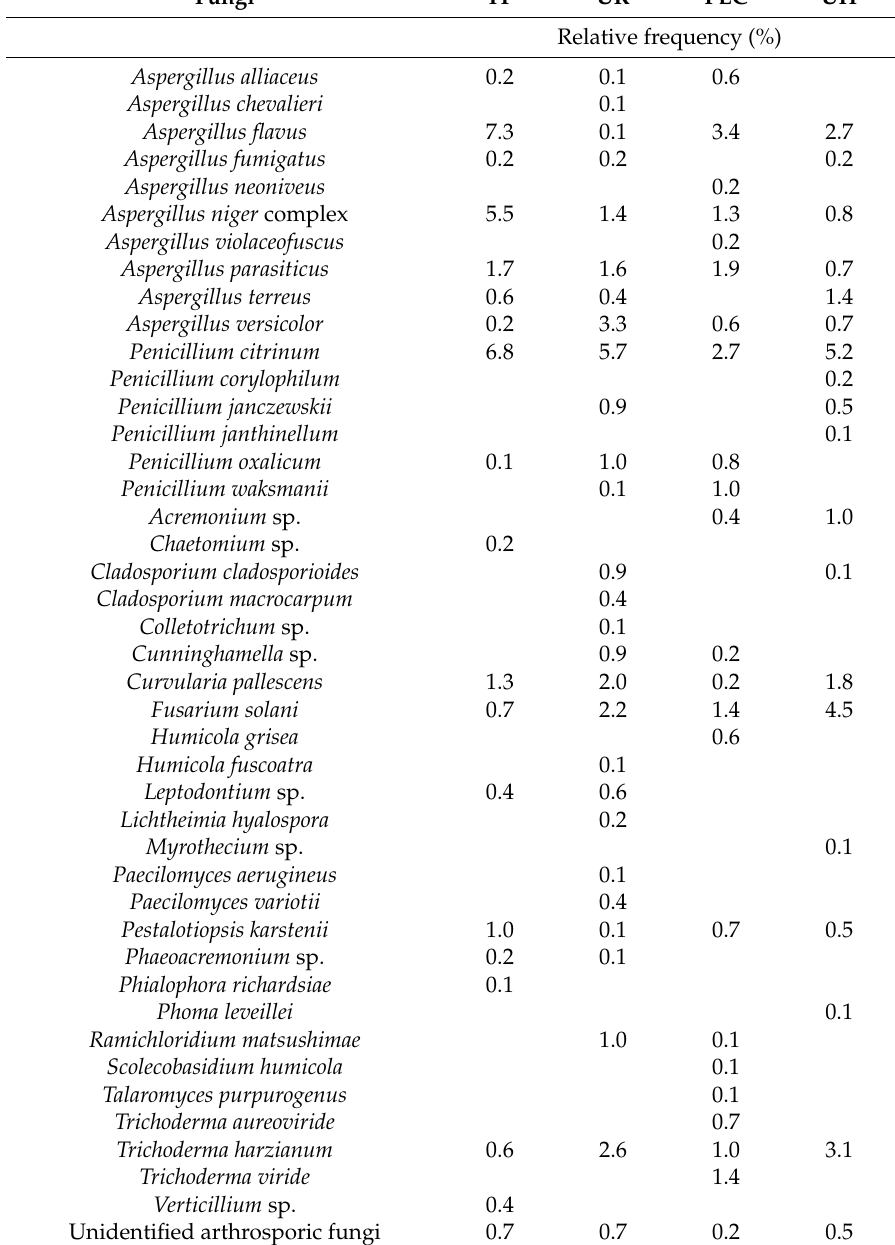
Table 2. Relative frequency distribution of fungal isolates from water in the sampling